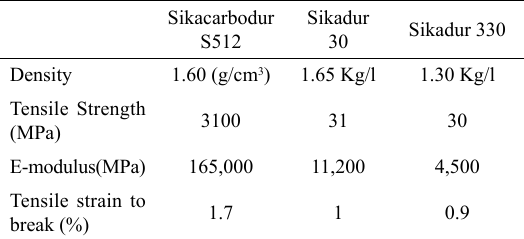
Table 1. Manufacturer mechanical properties of Sikacarbodur S512, Sikadur 30 and Sikadur 330